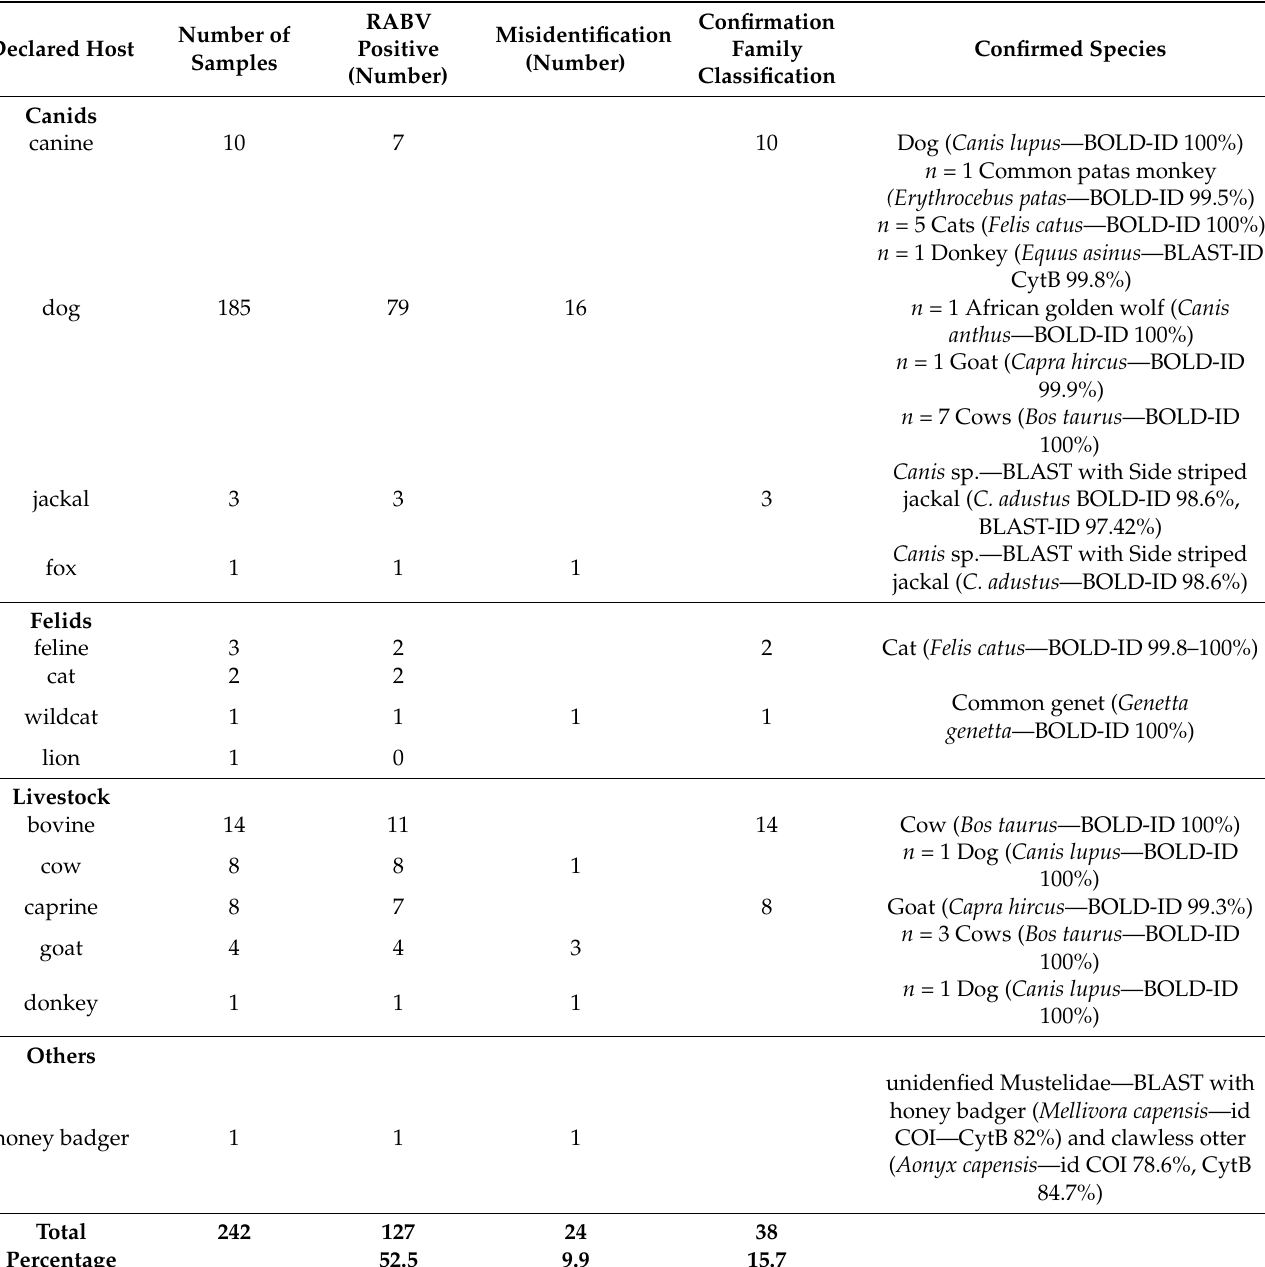
Table 1. Samples investigated for both rabies diagnosis and genetic identification of the host species. We considered a genetic confirmation of the host species for genetic identity (id) higher than 99% in the COI gene, using BOLD (indicated as BOLD-ID) or in the CytB, using BLAST (indicated as BLAST-ID). When the genetic identity was lower than 99%, the species with the highest genetic id for either COI and/or CytB, as found using BLAST, is